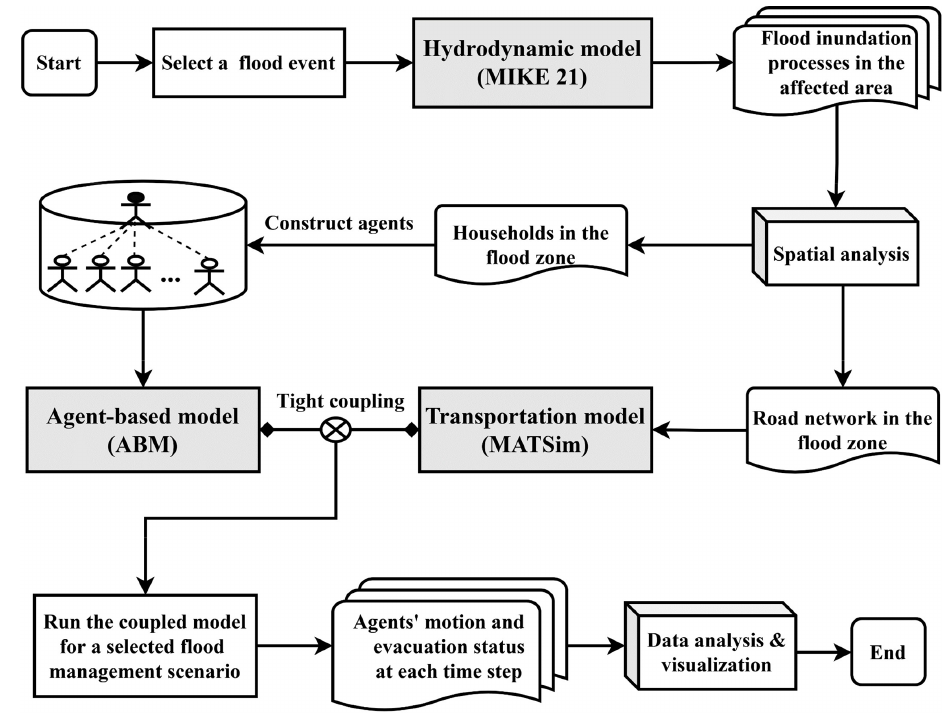
Figure 3. Flowchart of the integrated modeling framework.